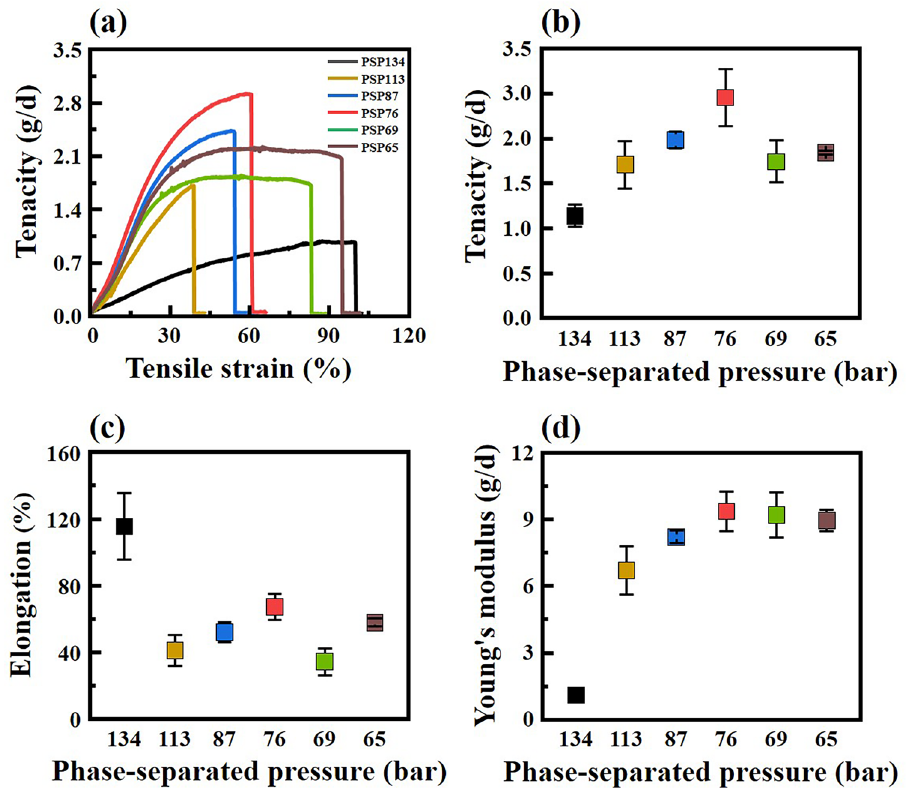
Figure 7. Mechanical properties of FSFs obtained at different PSPs. ( a ) strain–stress curves, ( b ) tenacity, ( c ) elongation, and ( d ) Young’s